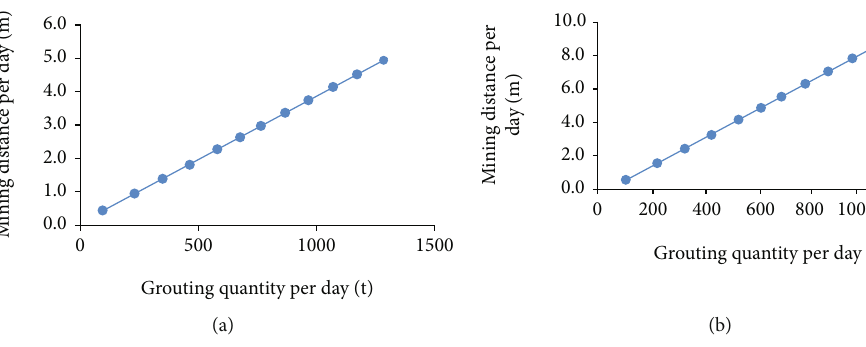
Figure 8: The excavation speed vs injection speed ((a) panel width 187 m; (b) panel width 127